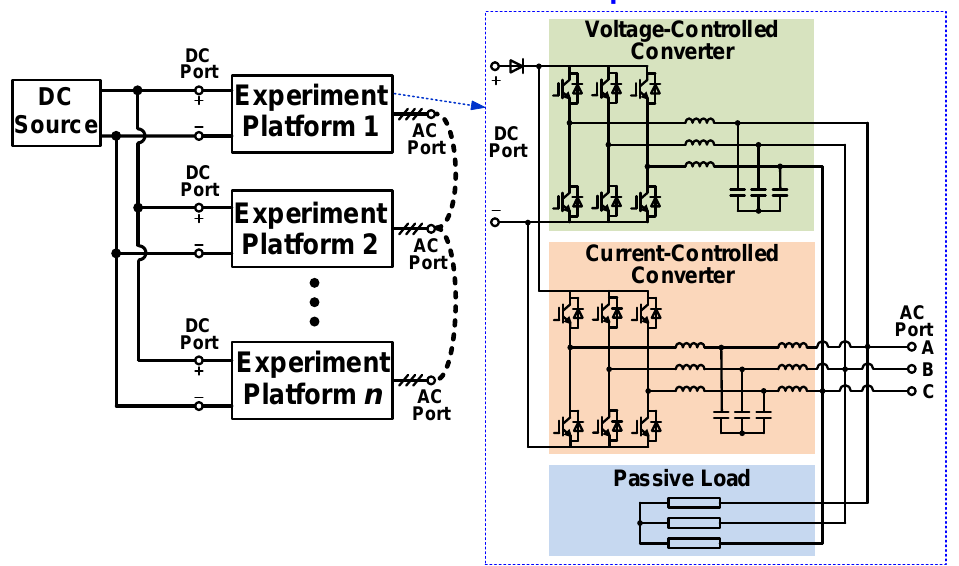
Figure 2. Power circuit of the proposed emulation approach.